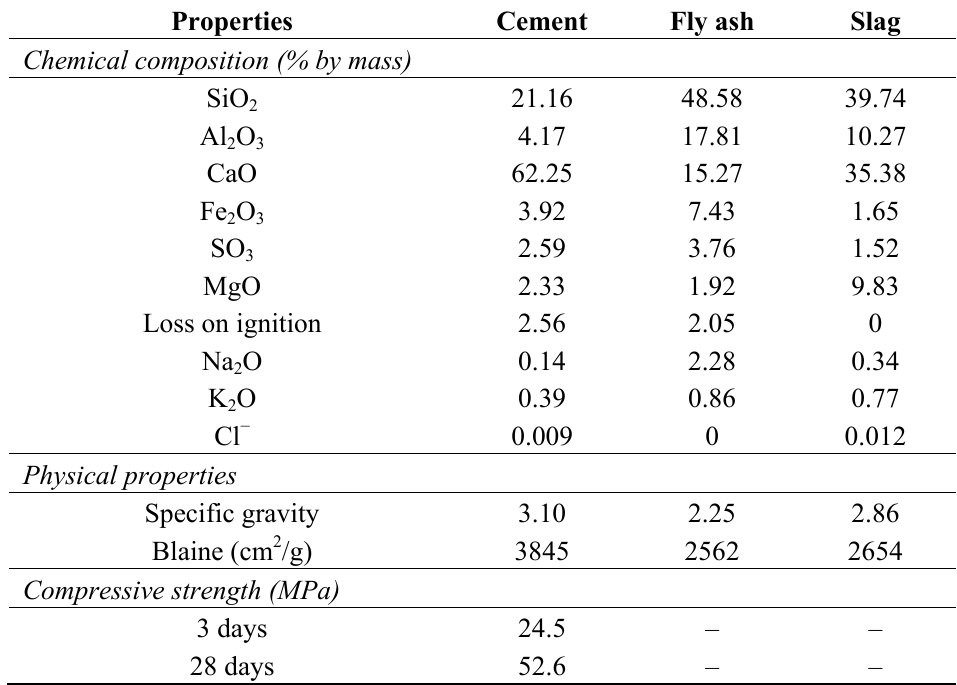
Table 3. Properties of cement, fly ash and slag.